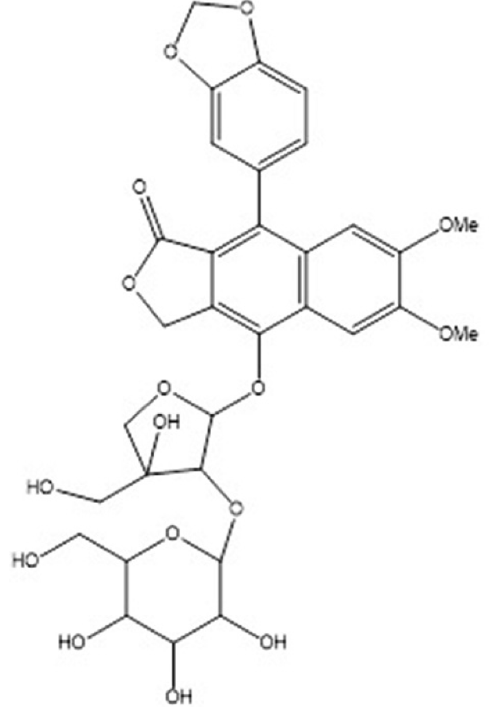
Figure 2. Chemical structure of procumbenoside B.